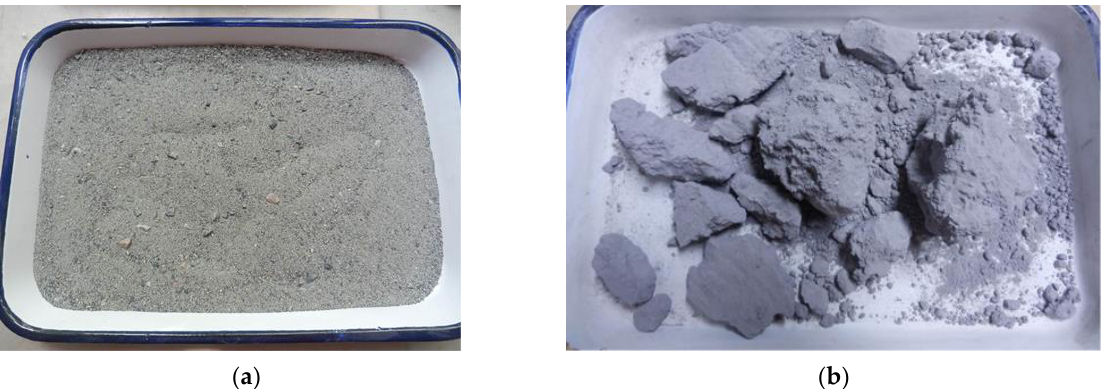
Figure 1. Accumulation states of iron ( a ) ore tailing sand and ( b ) phosphogypsum.